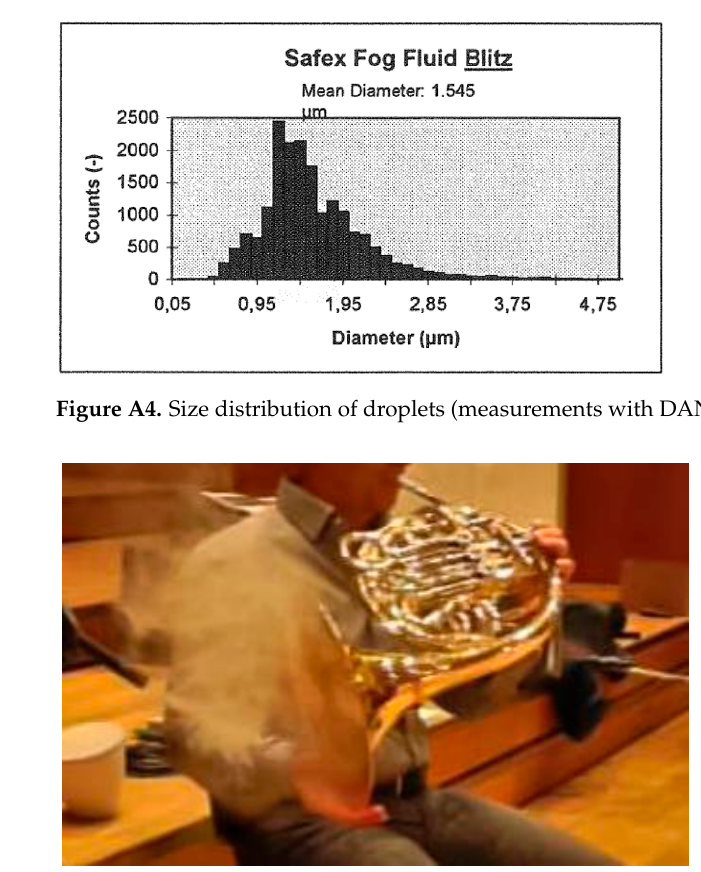
Figure A3. Test set-up on stage of the Bamberg Symphony Hall.